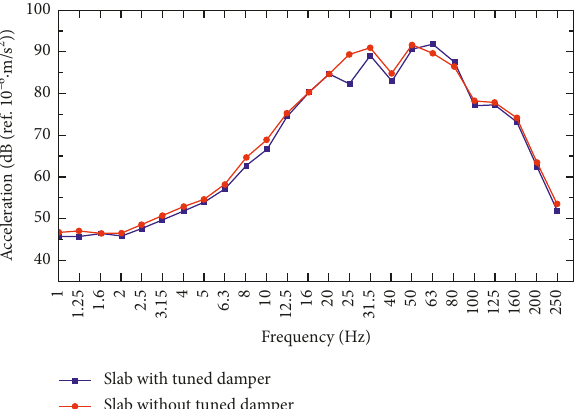
Figure 17: 1/3 frequency path spectrum of the track plate (hammered at the middle point between adjacent fasteners).